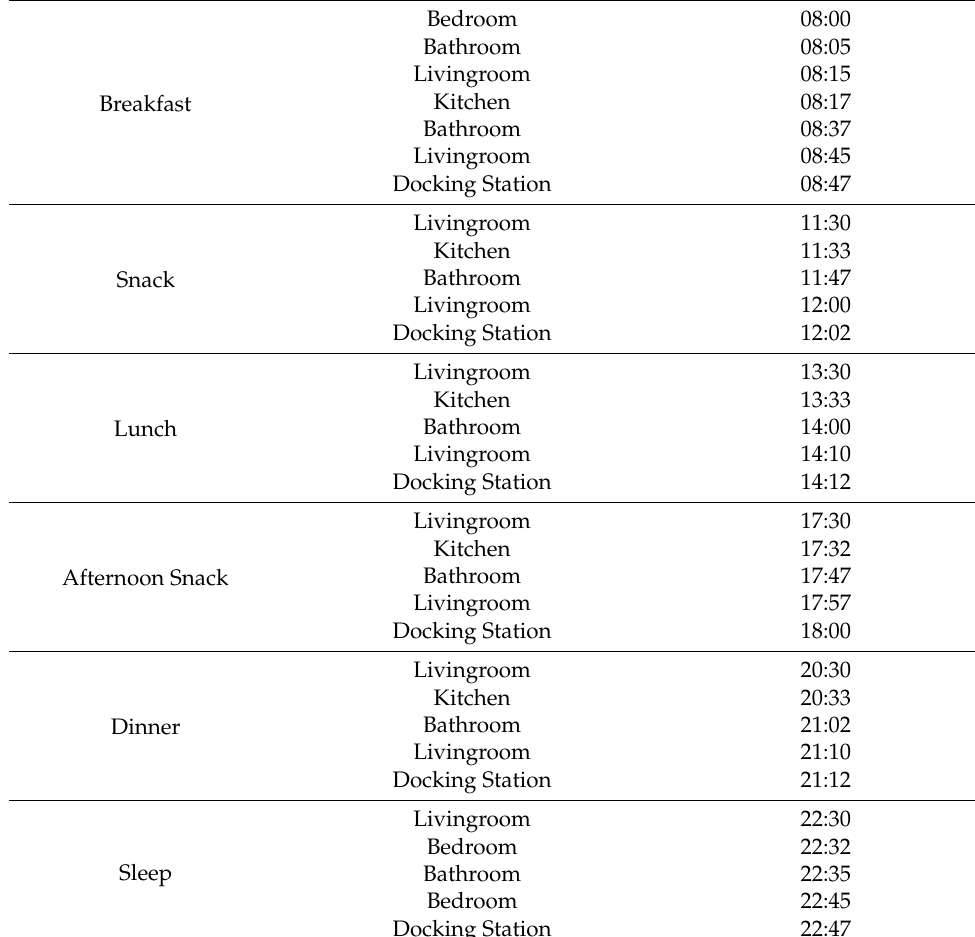
Table 4. Navigation